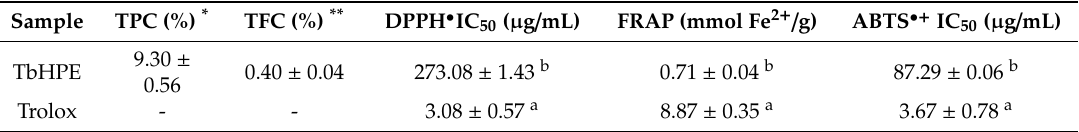
Table 1. Quantifications of polyphenols (TPC) and flavonoids (TFC) contents, antioxidant activity (DPPH • , FRAP and ABTS · + methods) from hydroethanolic pollen extract collected by Scaptotrigona a ffi nis postica (TbHPE).